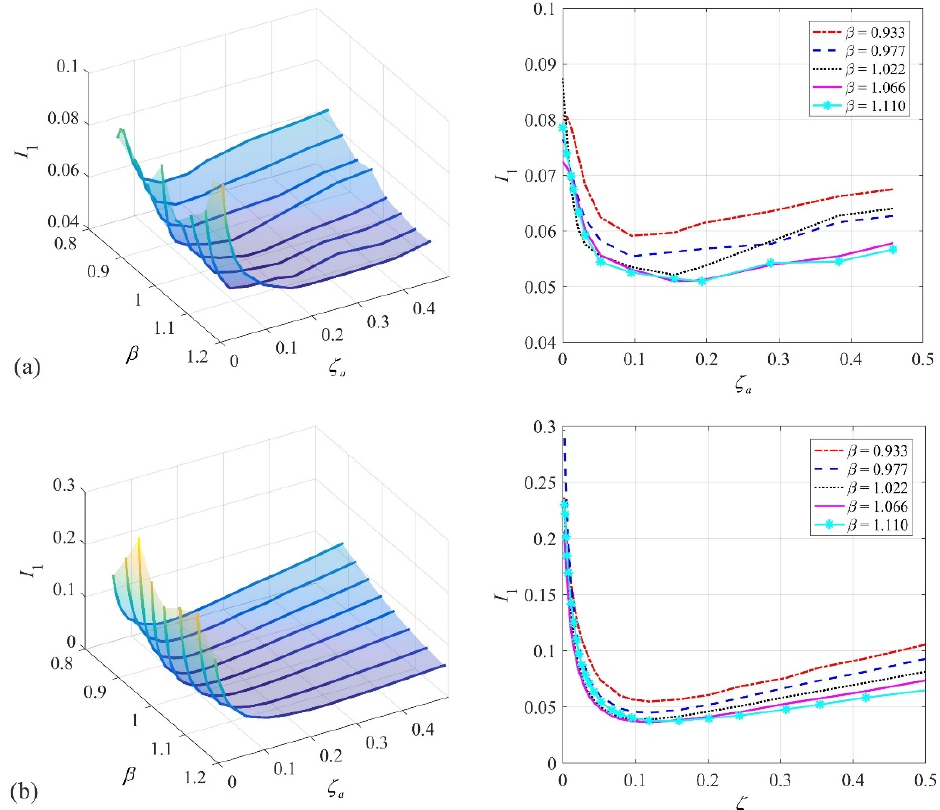
Figure 13. 3D and 2D plots of I 1 with µ = 0.050: ( a ) experimental result; ( b ) simulation result.